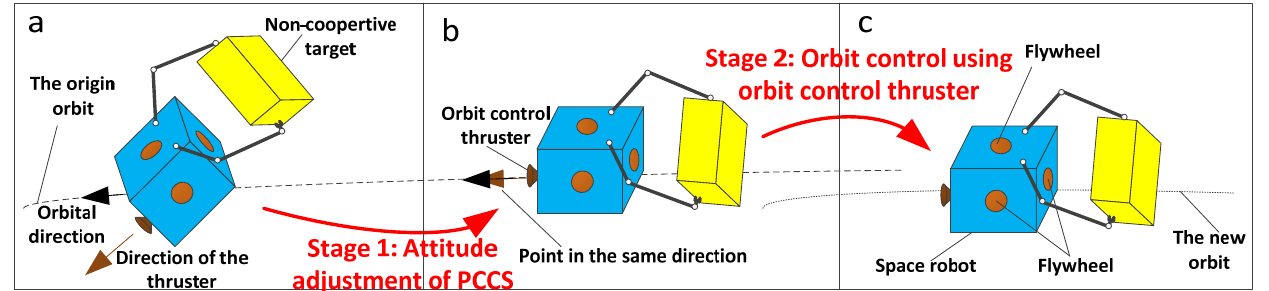
Figure 5. Flow of the orbit change task. ( a ) Initial state of PCCS. ( b ) Attitude adjustment of PCCS. ( c ) Orbit maneuver of PCCS.